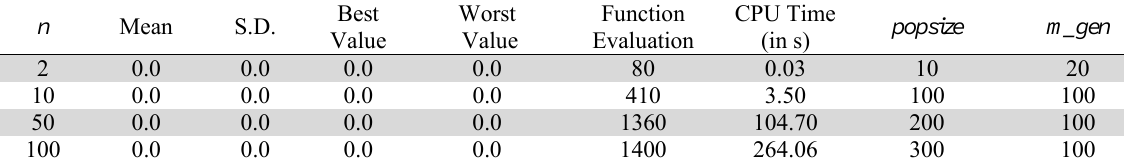
Computational Results of Problem -5